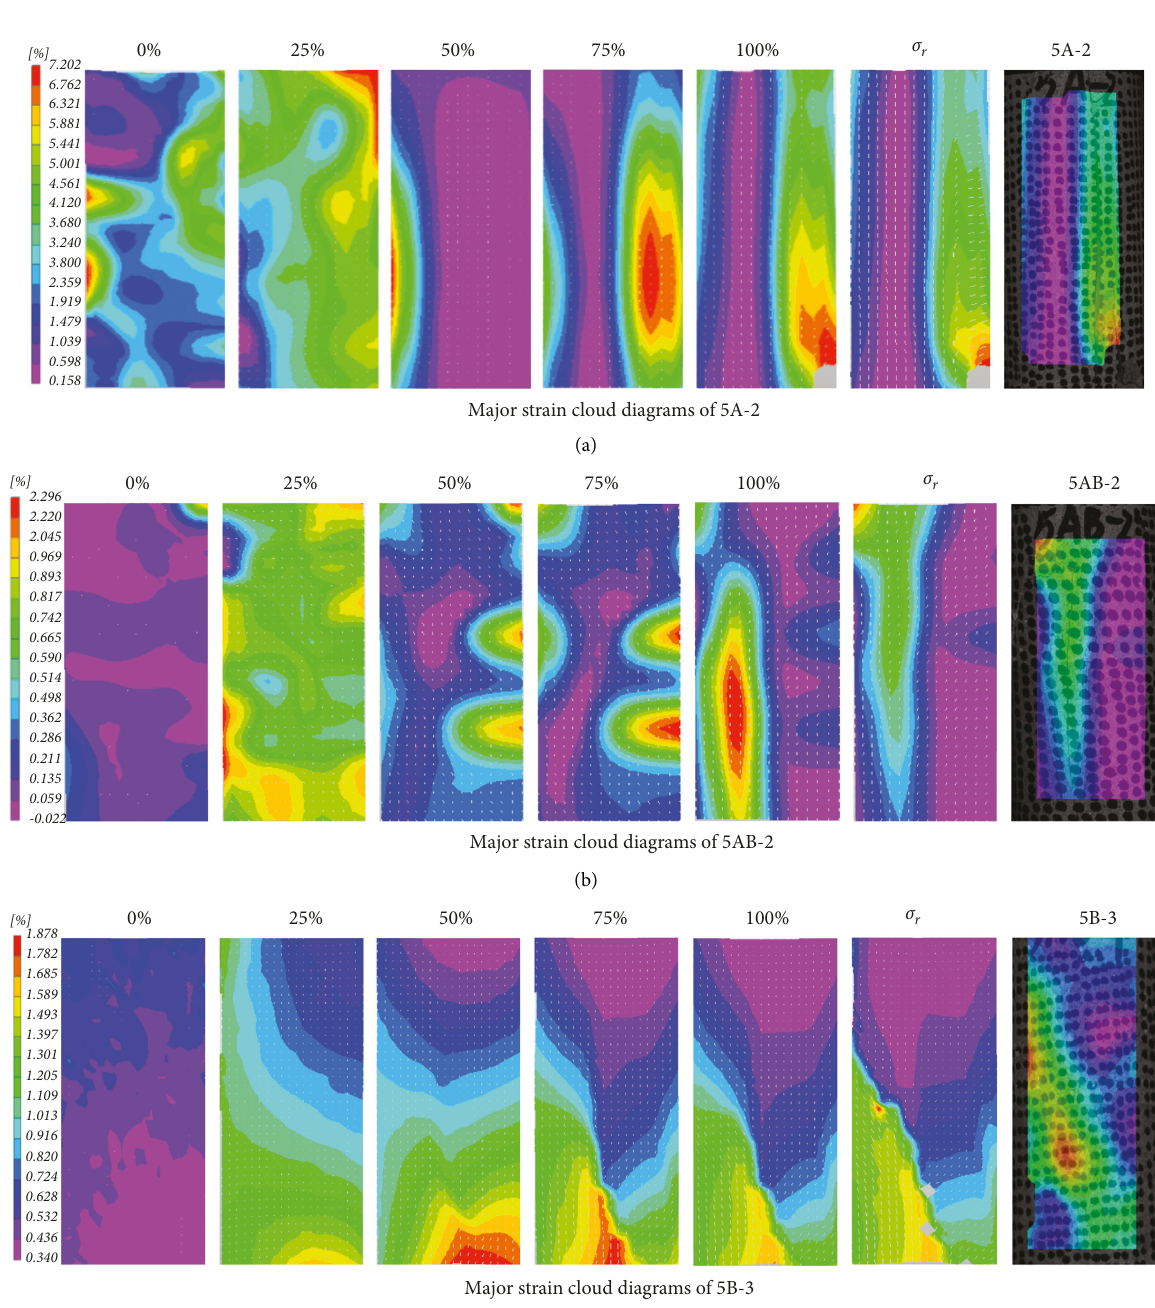
Figure 10: Major strain cloud diagrams of rock specimen. (a) Major strain cloud diagrams of 5A-2. (b) Major strain cloud diagrams of 5AB-2. (c) Major strain cloud diagrams of